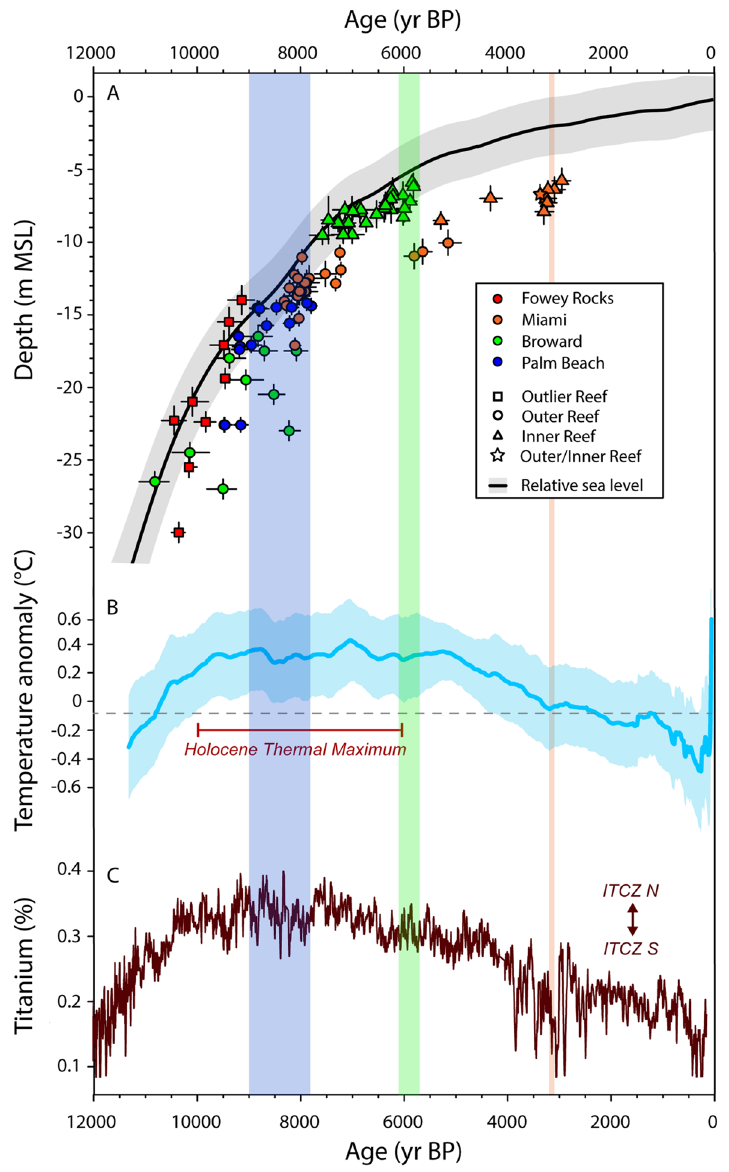
Figure 4. Reef growth by Acropora palmata on the Southeast Florida Continental Reef Tract compared with Holocene sea-level and climate variability. (A) A. palmata ages (± 95% confidence intervals [CIs], horizontal uncertainties) versus Holocene relative sea level in southern Florida 53 plotted by depth relative to MSL (± 95% CI). Vertical uncertainties for A. palmata ages are 95% CIs of the root-sum-squares of estimated elevational uncertainties (see Toth et al. 50 ). (B) Global composite of Holocene temperature anomalies 24 (± 95% CI; see Supplementary Discussion). (c) Variability in the position of the inter-tropical convergence zone (ITCZ) inferred from Titanium flux to the Cariaco Basin (Ti%) 25 . Vertical shading represents the timing of reef termination in each subregion (width of shading is range from peak of KDE to youngest age at each